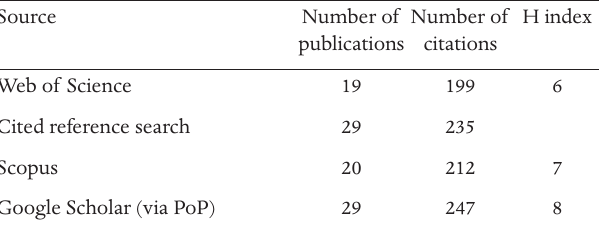
Table 1. Computation of the author’s personal score as an example of the use of the different databases. Comparison of the number of published papers, the citation index and the H-index according to ISI (two computations), SCOPUS and Google Scholar. The scores vary a lot across the different sources, and show variations of up to 50%. The choice of a specific database biases the (absolute) rate of the single scholar, although it probably affects comparisons between scientists only if their scientific production is very dissimilar (many books or conference papers versus journal